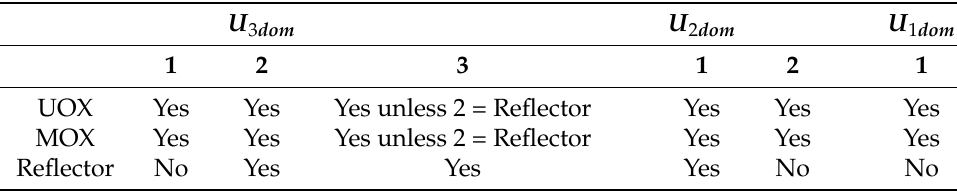
Table 2. Table showing possible systems within the smaller data set. The rows represent the material type of domain, and the columns represent the location and how many domains are used in the